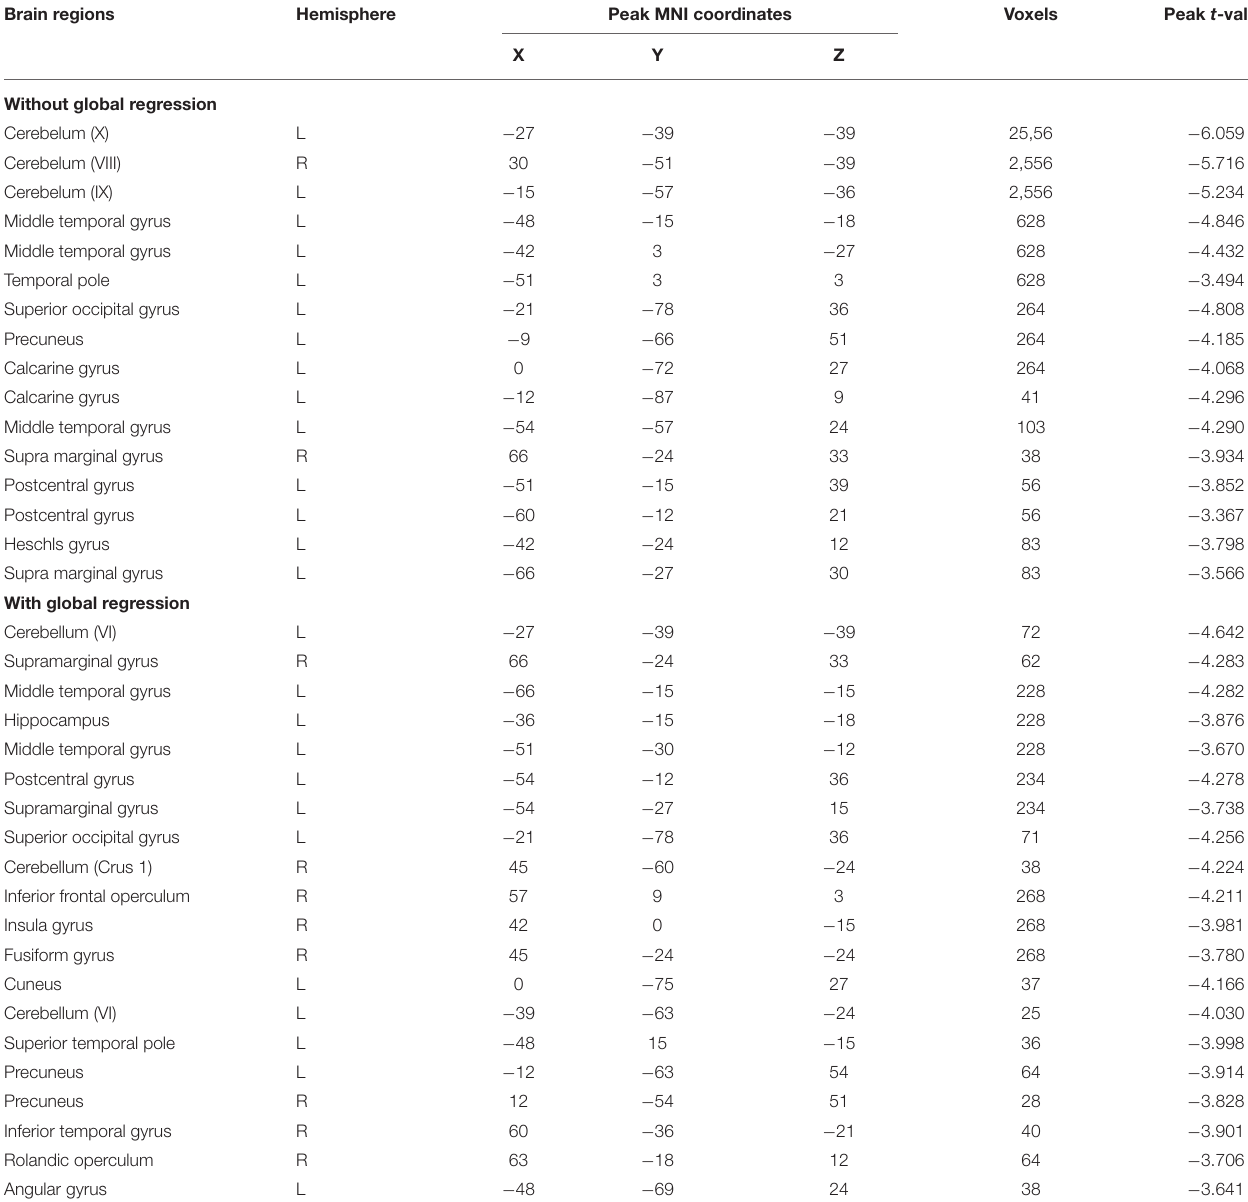
TABLE 2 | Between-group comparison of mean dReHo across sliding windows. Brain regions Hemisphere Peak MNI coordinates Voxels Peak t